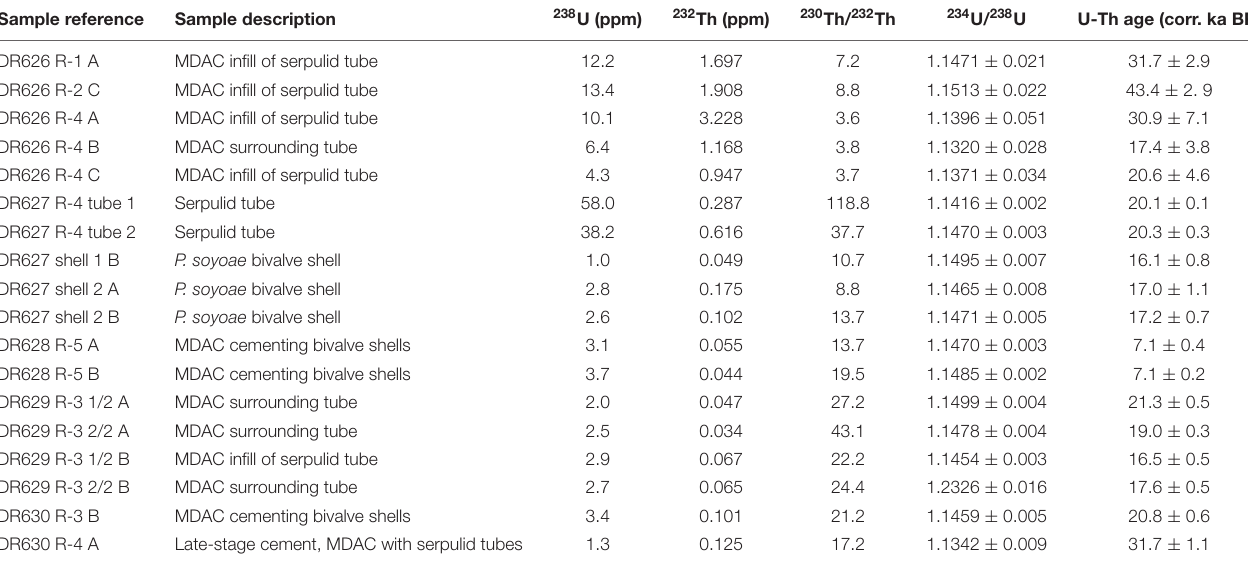
TABLE 2 | U-Th composition and age interpretation of Fossil Hill methane-derived authigenic carbonate (MDAC) samples and shells and